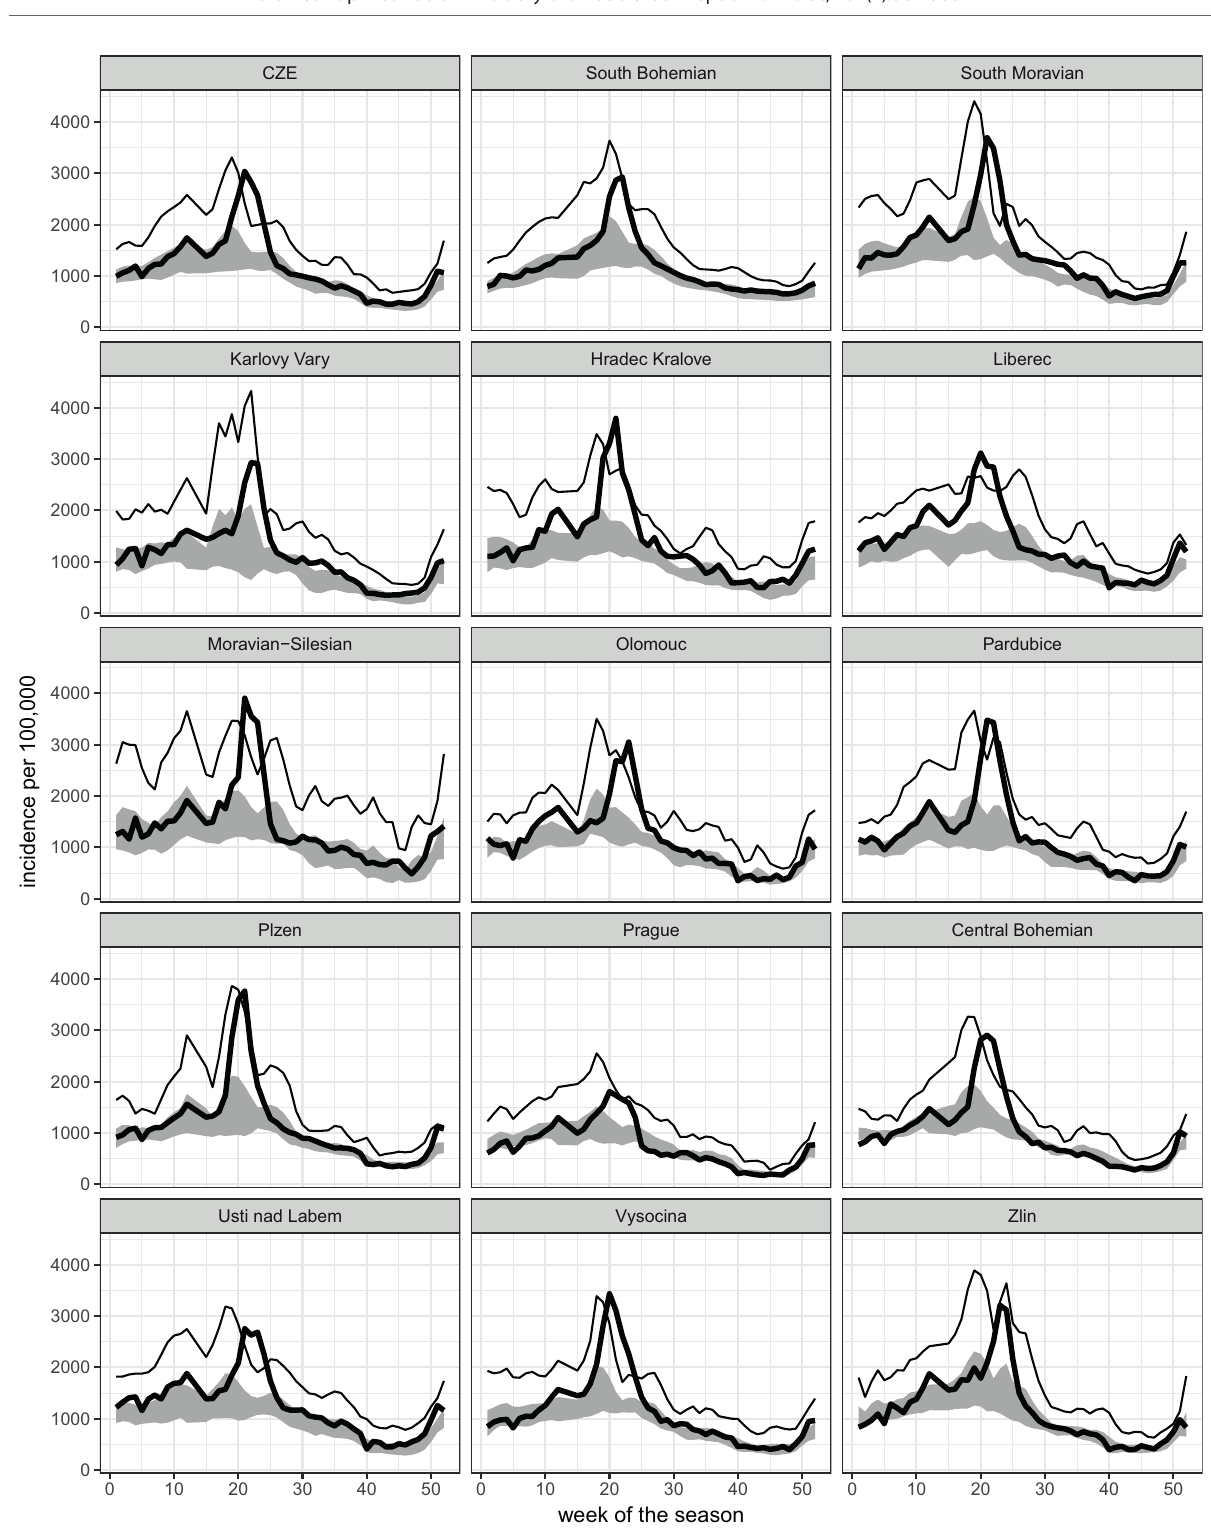
Fig. 3. Visualisation of ARI time course in the Czech Republic and its regions during the season 2004/05 (thick line) compared to the functional boxplot where the usual values fall into the grey area and the outlying values are above the thin line. high for that period of the year but smaller than the usual yearly maximum. The usual peak observed before week 20 was absent. There is a clear epidemiological explana- tion for this phenomenon: the influenza pandemic that affected the world in